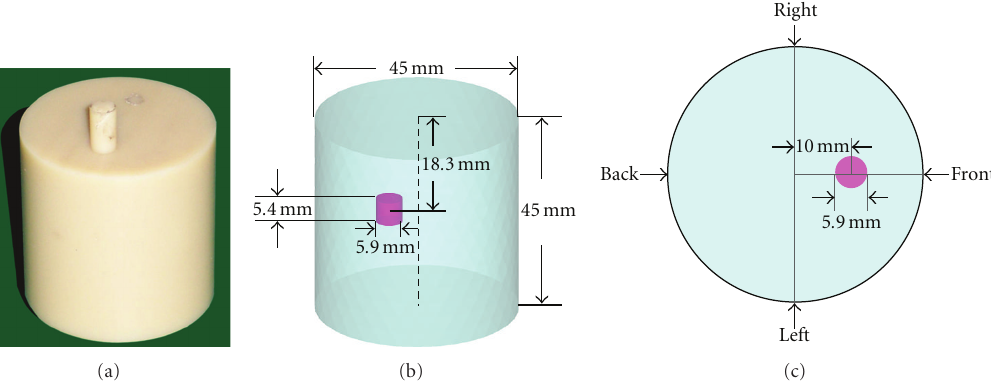
Figure 5: Physical phantom. (a) The homogeneous physical phantom; (b) The location of the single source in the phantom; (c) The cross- section of the phantom and the four directions of the CCD camera during data acquisition.